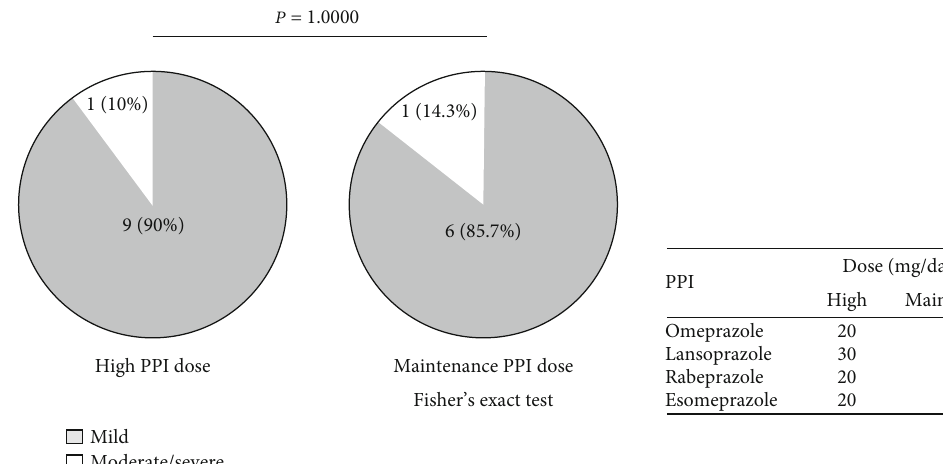
Figure 1: Comparisons of the clinical manifestation of upper gastrointestinal bleeding (estimated amount of bleeding, shock index, and total amount of blood transfusion) between 17 patients with and 80 patients without daily usage of proton pump inhibitors (PPIs). The mean estimated bleeding volume and SI in the habitual PPI users were both signi fi cantly less than those among the non-habitual users, respectively ( P < 0 : 05 ). Meanwhile, there was no signi fi cant di ff erence in the average volume of packed red blood cell volume transfused while being hospitalized between patients ’ groups of habitual or nonhabitual PPI users ( P > 0 : 05 ).